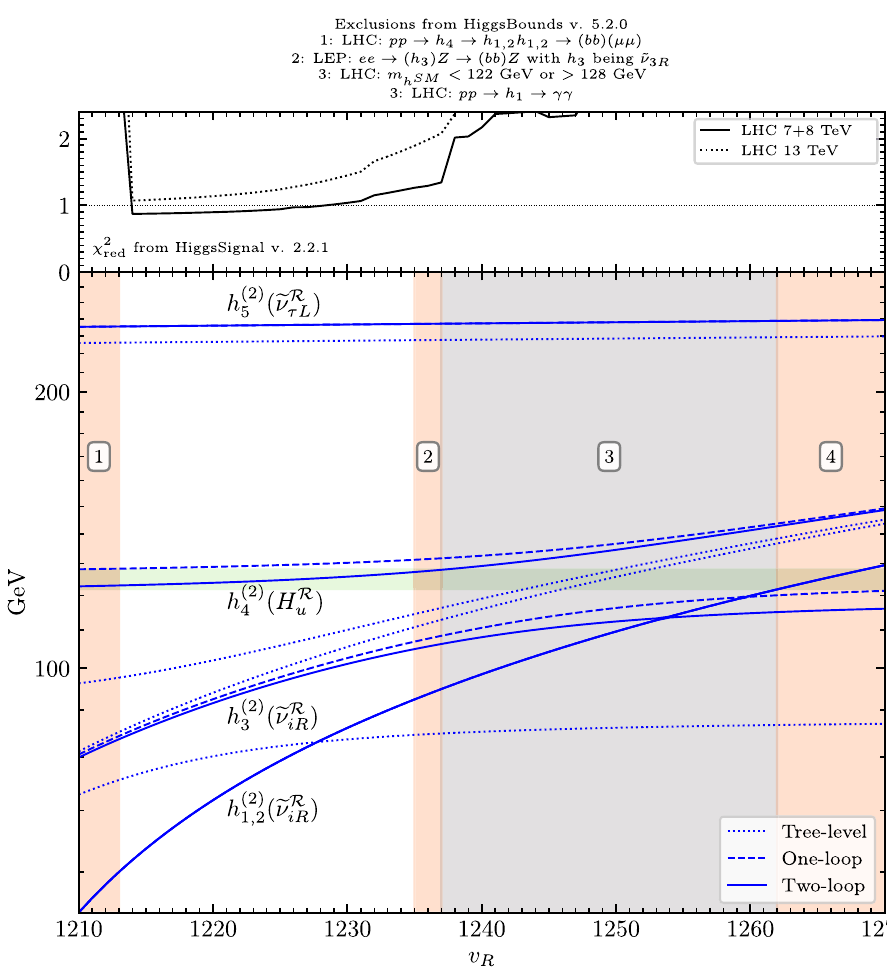
Fig. 7 Light CP -even scalar spectrum in the scan over v R . Shown are the masses at tree level (dotted), at the one-loop level (dashed) and at the partial two-loop level (solid). We show in the brackets the dominant composition of the loop-corrected mass eigenstates h ( 2 ) in the experimentally allowed region of v R . The desired SM-like Higgs-boson mass is indicated with the horizontal green band, assuming a theory uncertainty of 3 GeV. The red regions are excluded by direct searches for additional scalars. In the gray region the SM-like Higgs-boson mass is not predicted accurately. On top we show χ 2 for various red Higgs-boson signal strength measurements at